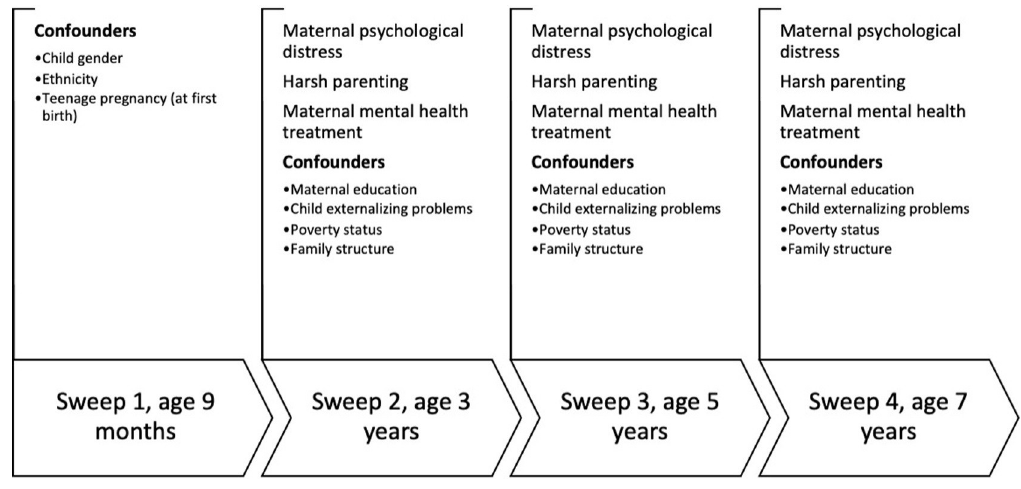
Fig 1. Flow chart of MCS waves with data used in this